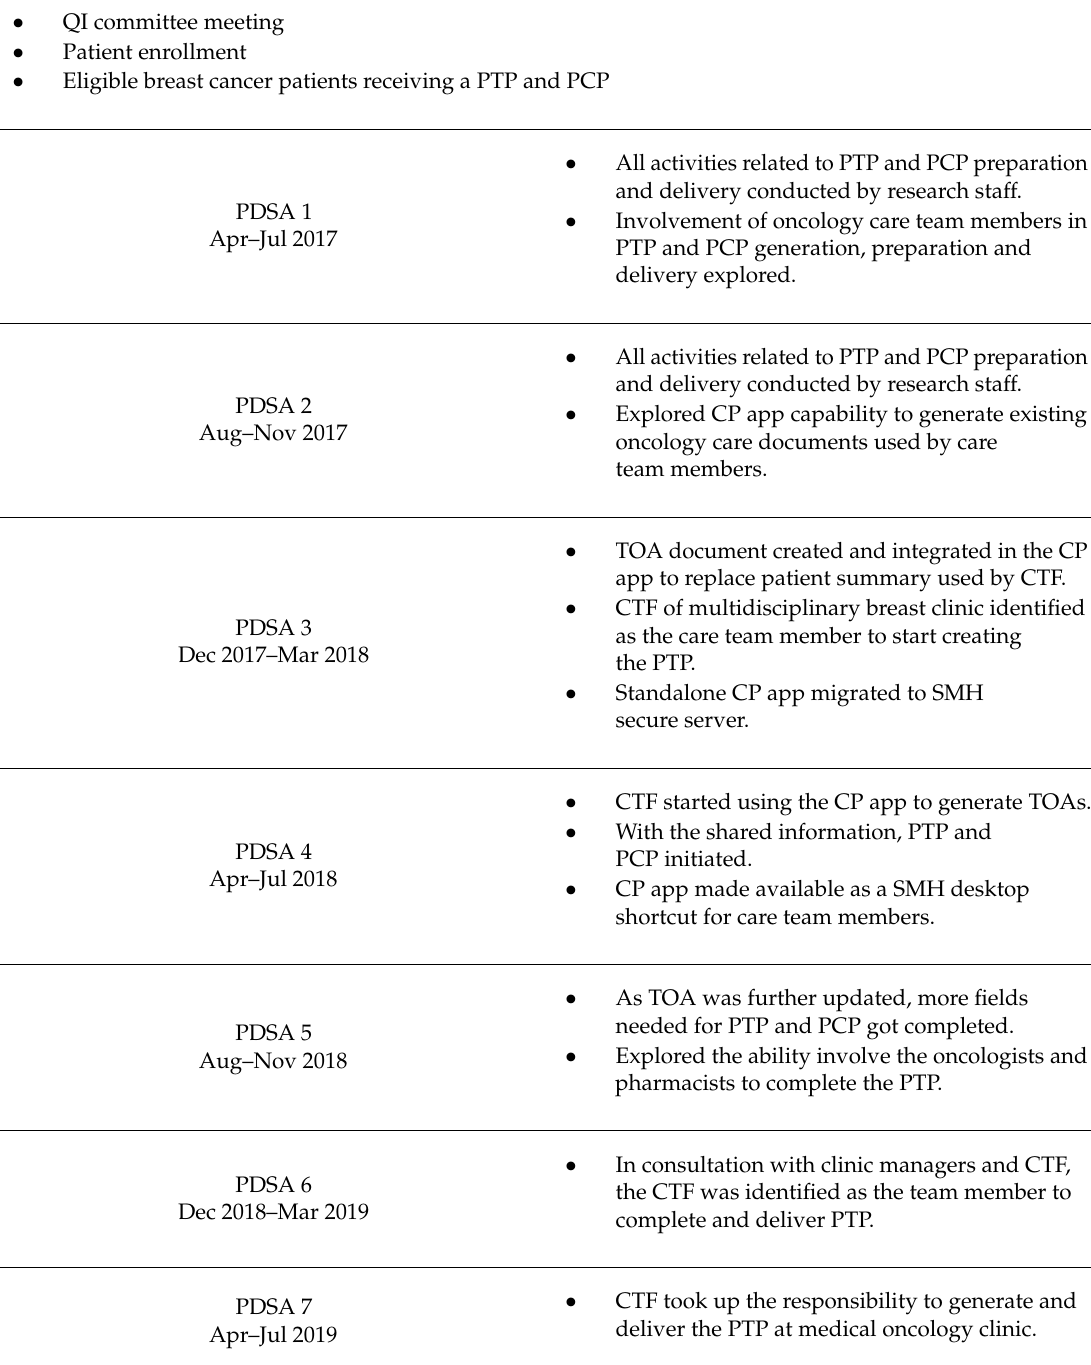
Table 1. Plan, do, study, act (PDSA) cycles and project progress. Each PDSA cycle started